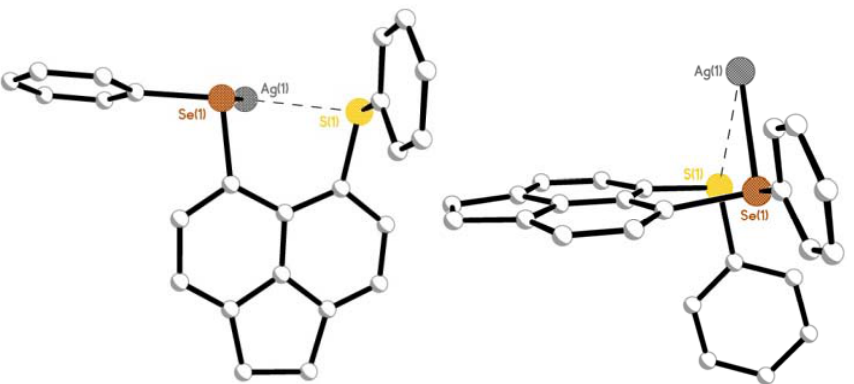
Figure 8. Short Ag1···S1 contacts in 4 and 5 construct 6-membered quasi -chelate rings which adopt twisted envelope type conformations (H atoms omitted for clarity; complex 4